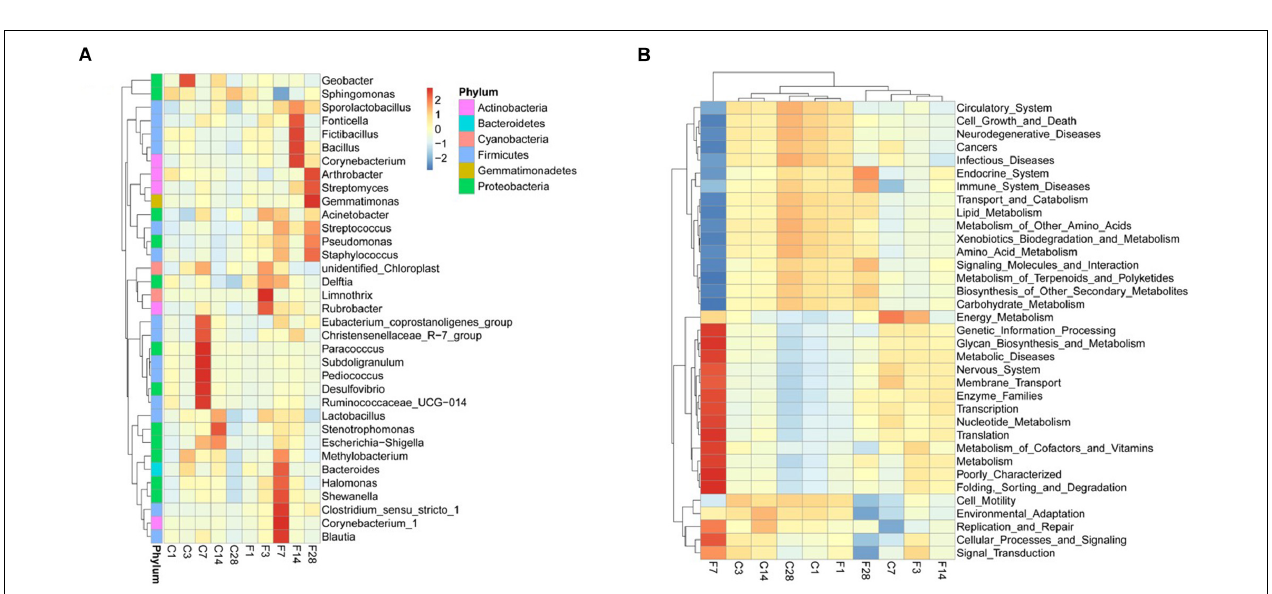
FIGURE 5 | The relative abundance of microbial communities at the level of class (C, the group treated with saline; F, the group treated with influenza virus; the number followed C/F represented the day post inoculation). The majority of the OTUs were dominated by ten classes: Alphaproteobacteria , Gammaproteobacteria , Bacilli , Unidentified Actinobacteria , Clostridia, Bacteroidia , Mollicutes , Deltaproteobacteria , Betaproteobacteria, and Unidentified Gemmatimonadetes . Identities were established using sequence homology with 16S rRNA gene sequences. Different proportions of classes can be seen at different day post inoculation of the LRT. More than 85% of the reads belonged to these ten classes.